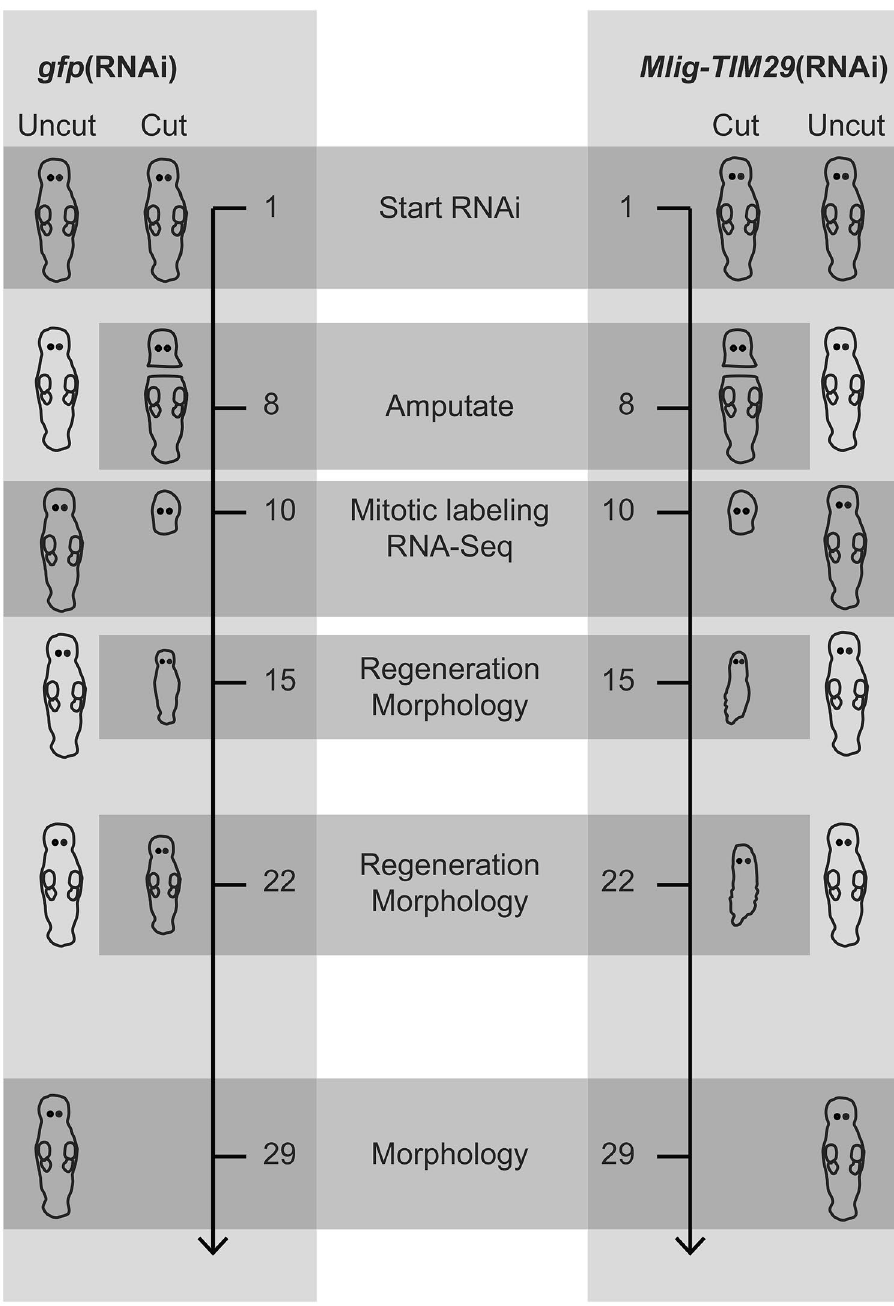
Figure 2. Experimental design of the Mlig-TIM29 (RNAi) study. The horizontal grey squares indicate which worms are used at each time point, represented by the number of